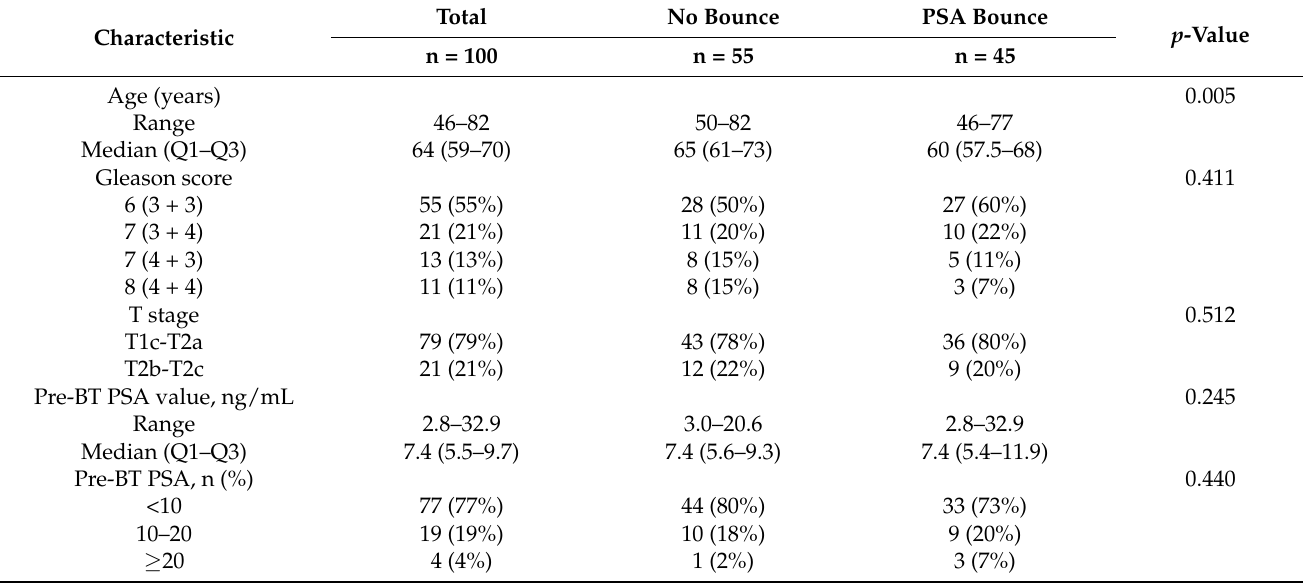
Table 1. Patients’